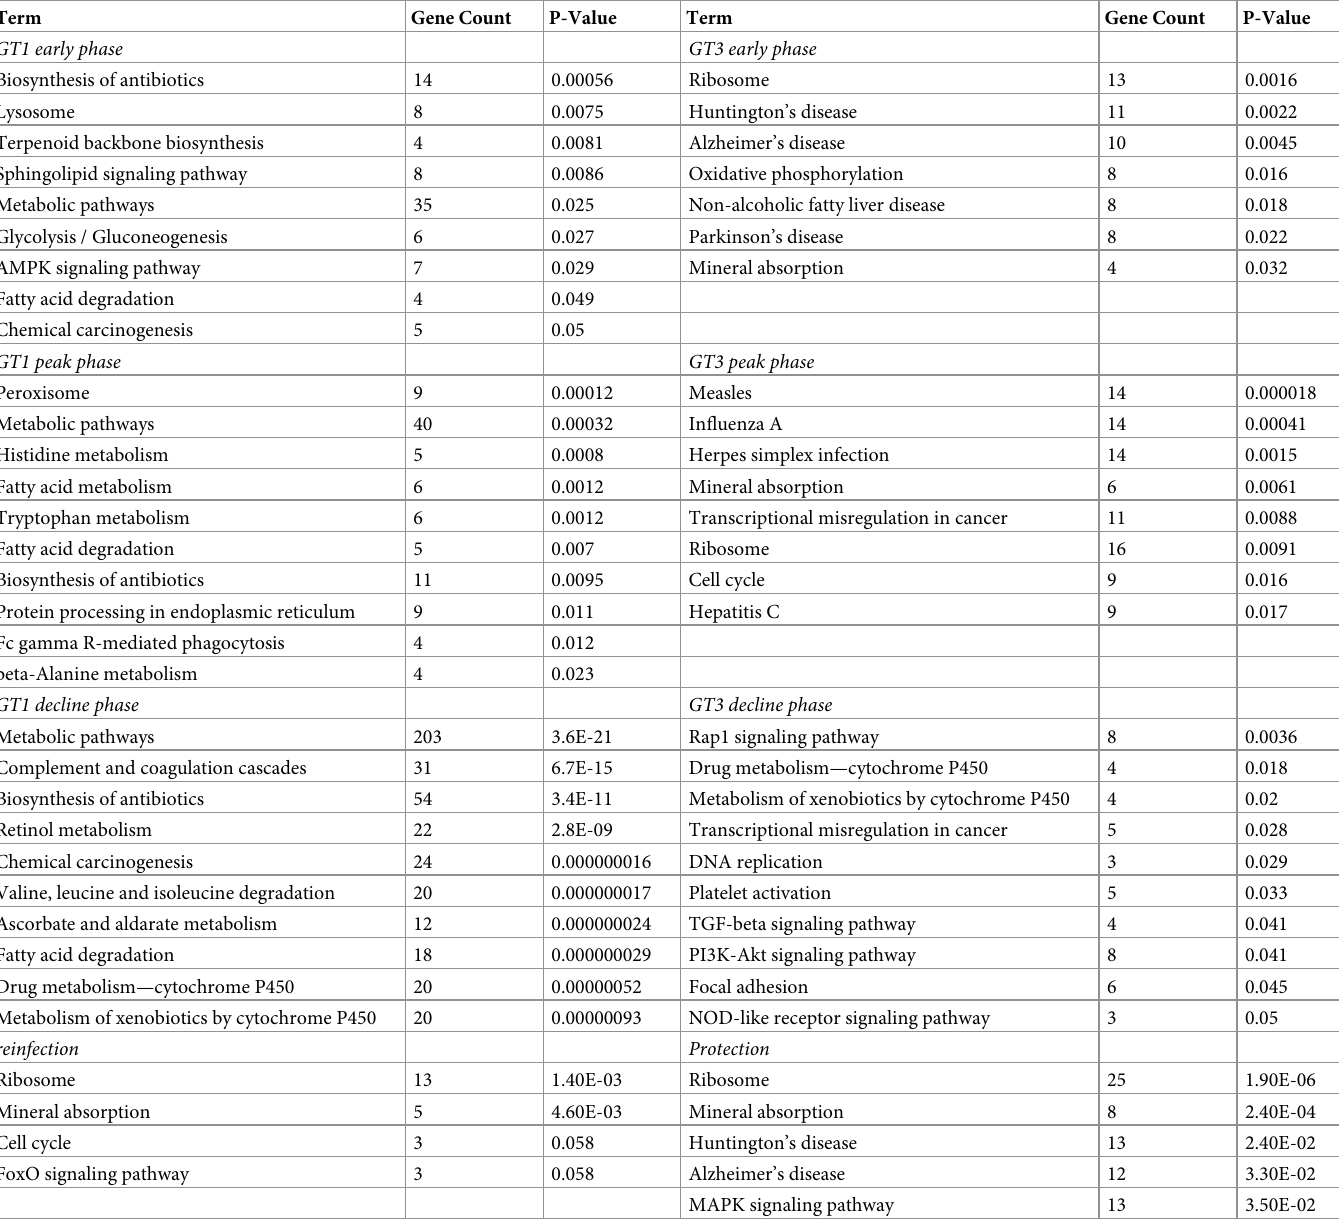
Table 2. Predictive KEGG pathway of the differently expressed genes in each phase of primary HEV gt1 and gt3 infections and homologous HEV gt1 reinfection.